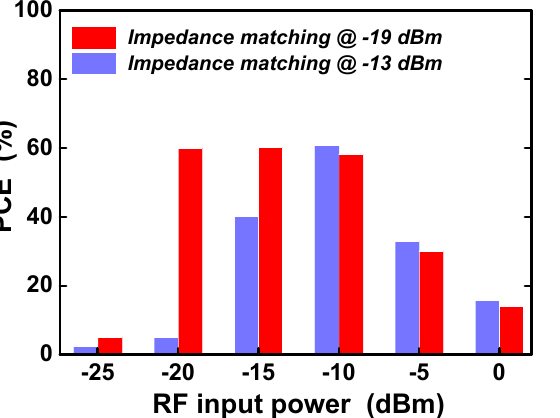
Figure 11. PCE according to RF input power under different input impedance matching values.